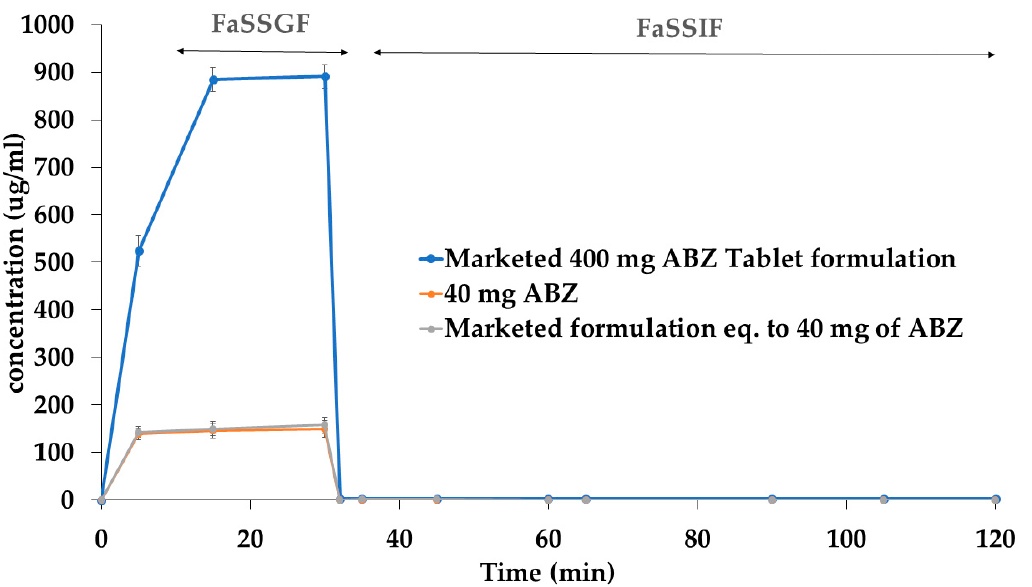
Figure 3. Transfer experiment results for ABZ (40 mg) and a marketed immediate-release tablet (40 mg and 400 mg).